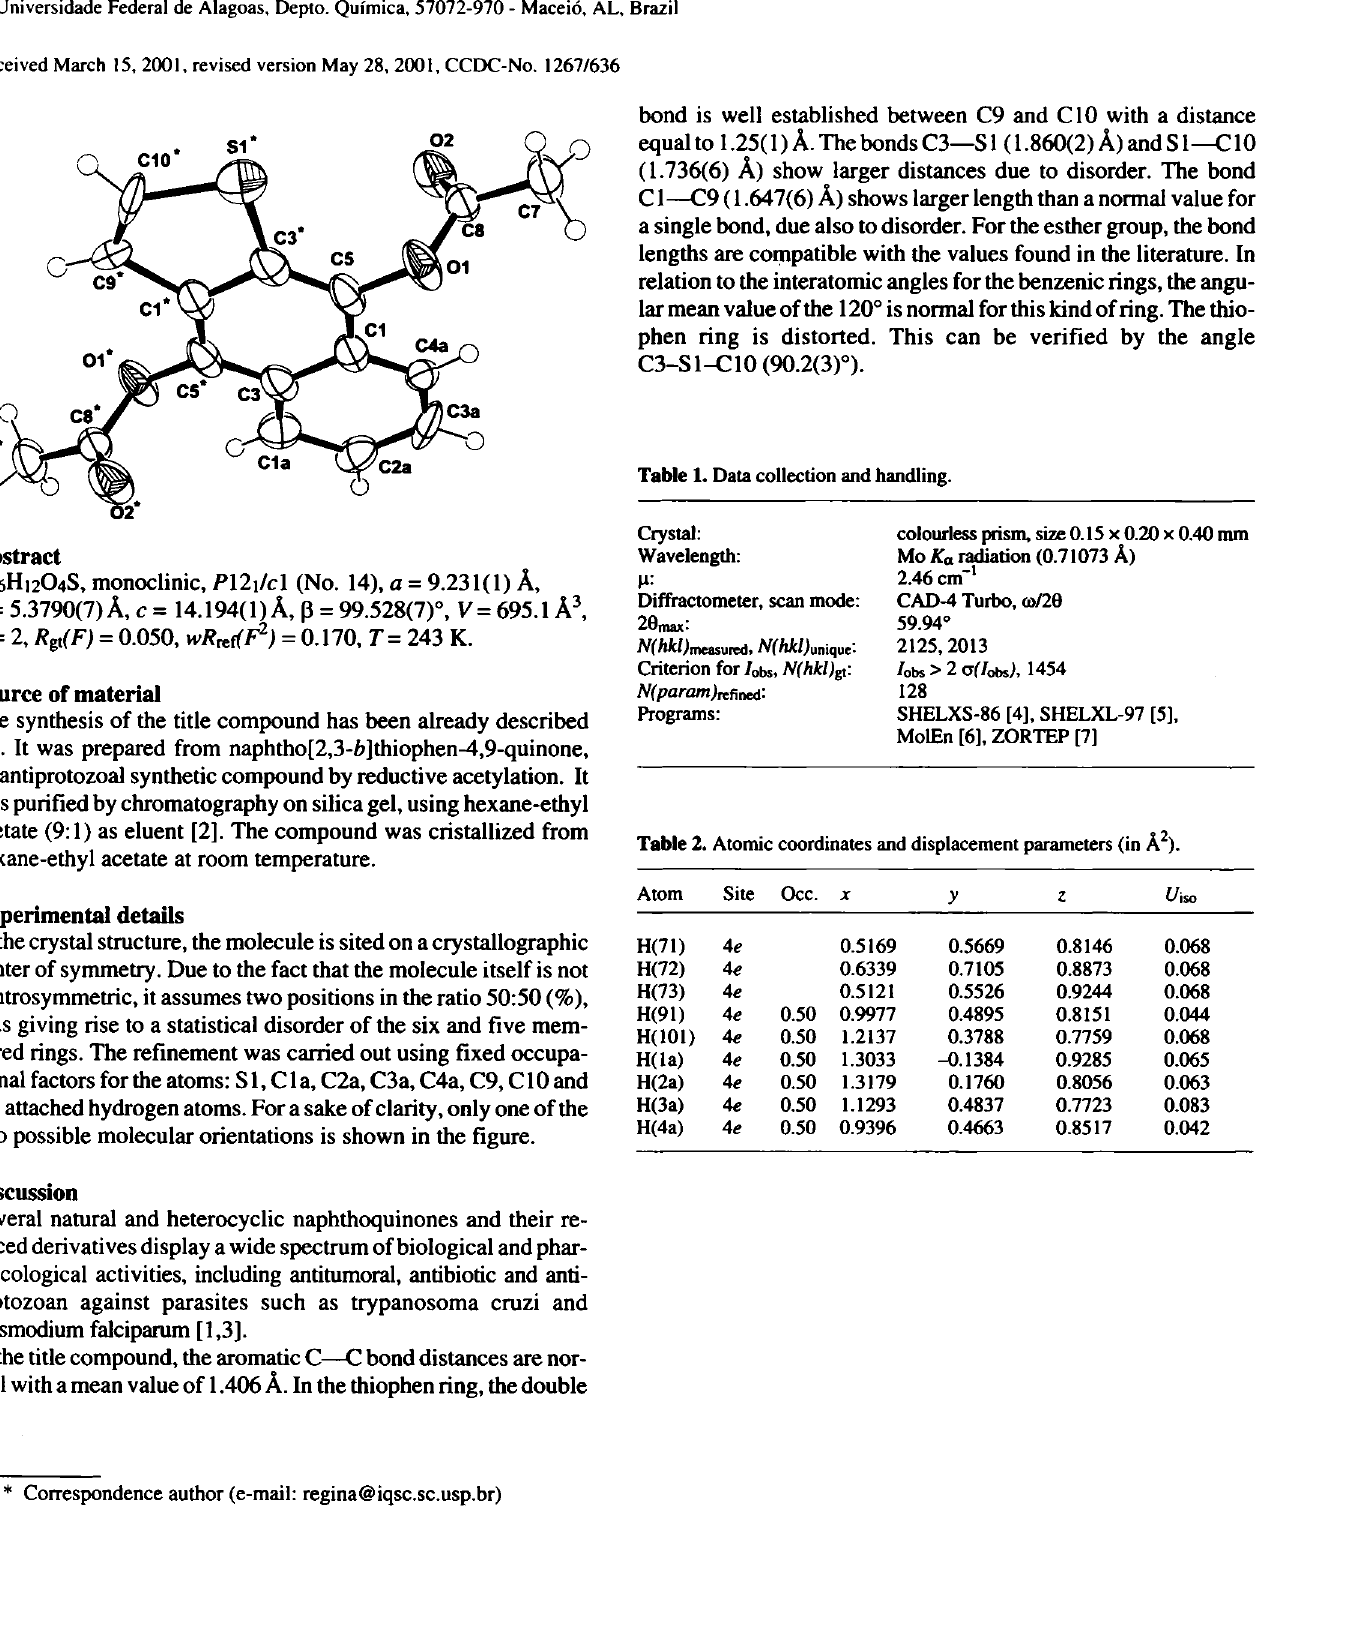
Table 1. Data collection and handling.